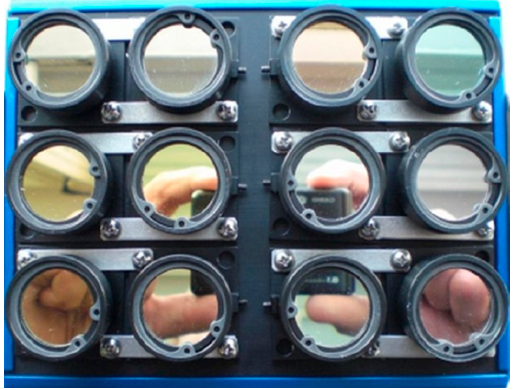
Figure 3. Tetracam Inc. miniature multi-camera array Mini-MCA 12 with mounted narrow-band (10–40 nm) filters that cover the spectral range between the visible and the near-infrared light (470–953 nm; both center wavelengths).